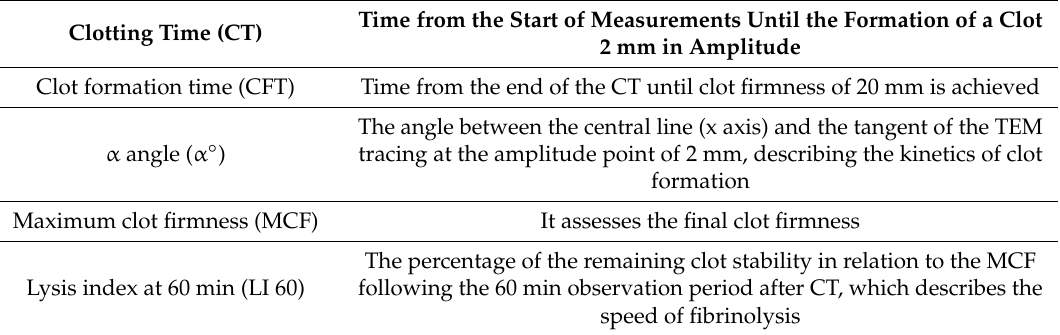
Table 1. Measured parameters of rotational thromboelastometry (ROTEM).